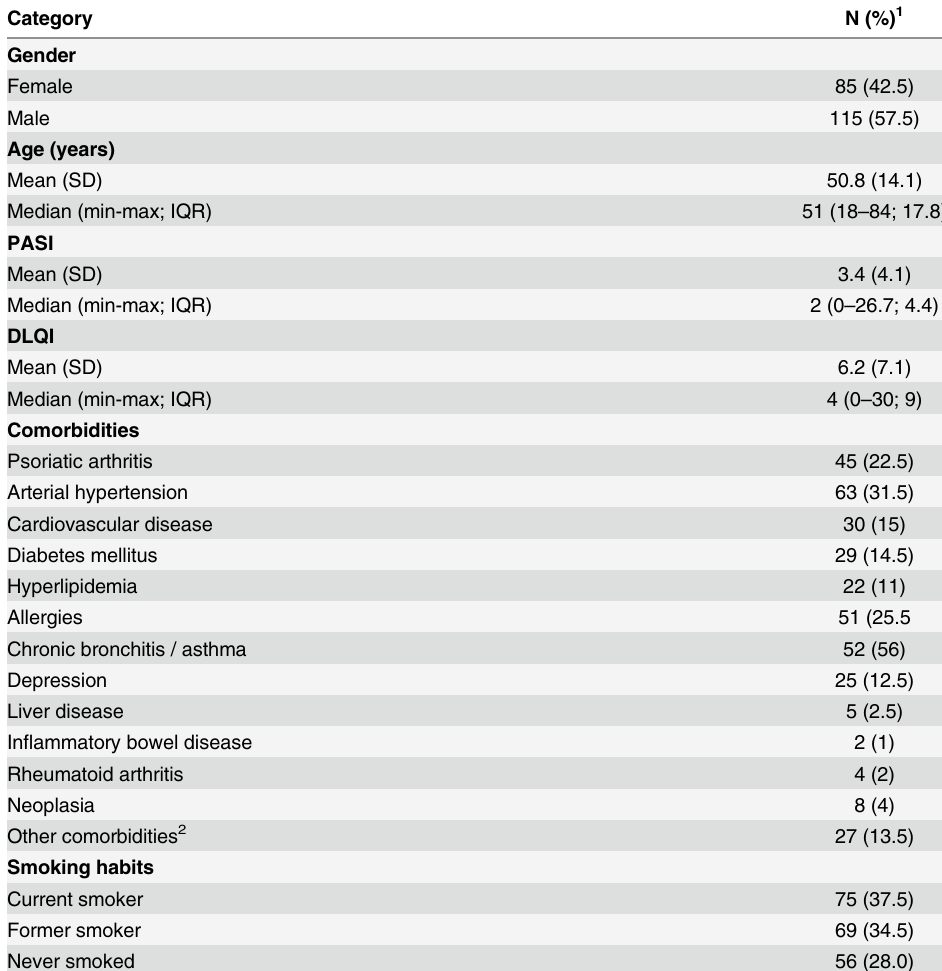
Table 1. Characteristics of the study